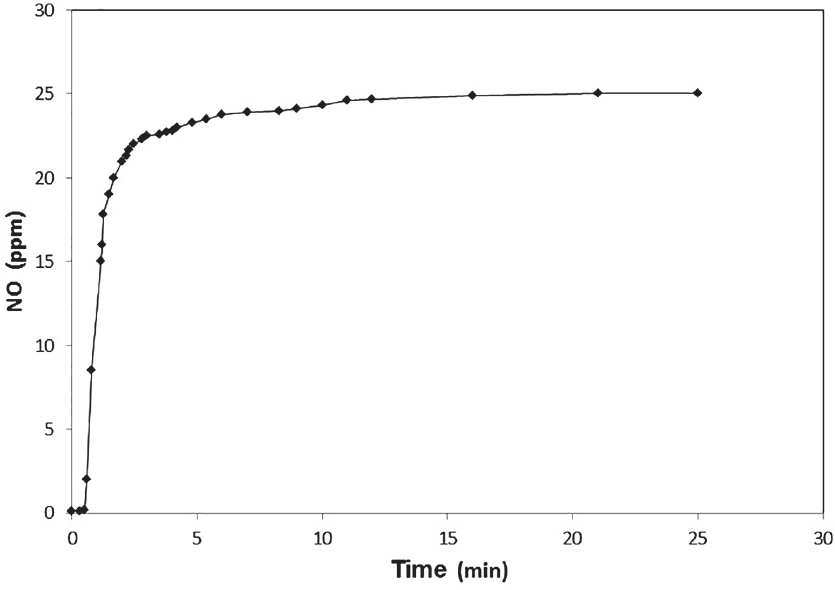
Figure 8 - Evolution of NO adsorption for the original viscose